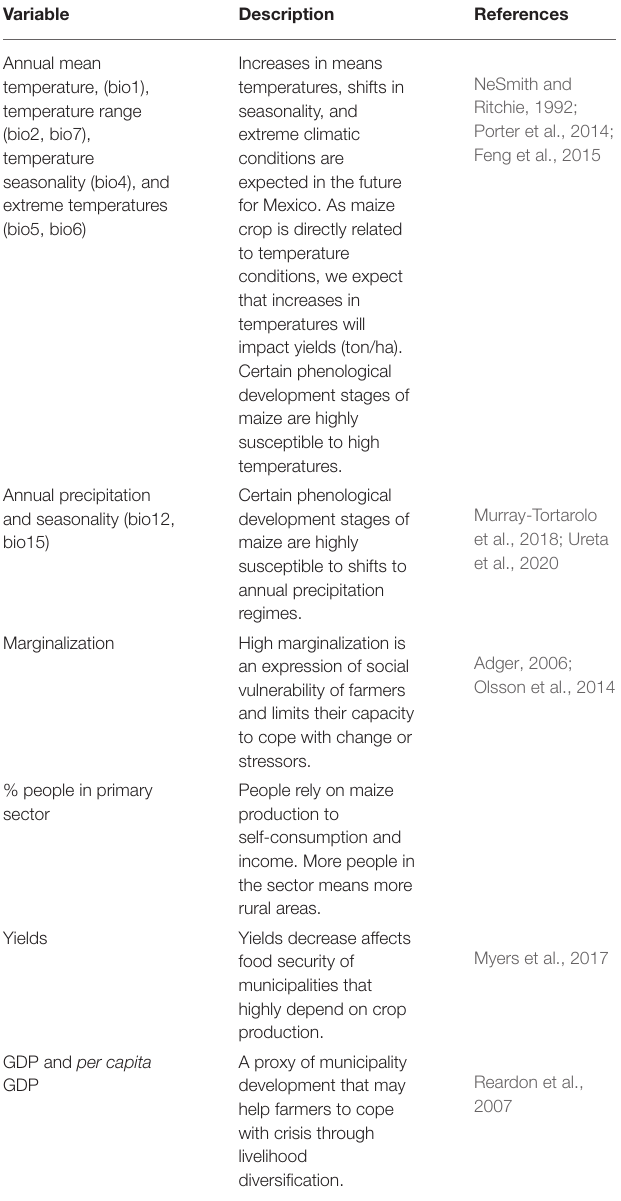
TABLE 2 | Description of socioeconomic and climatic variables and their assumed effects in maize agriculture.